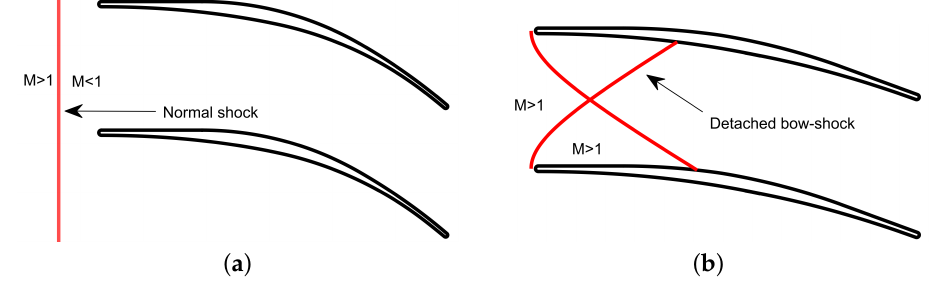
Figure 1. Comparison between unstarted ( a ) and started ( b ) condition for a supersonic blade row.